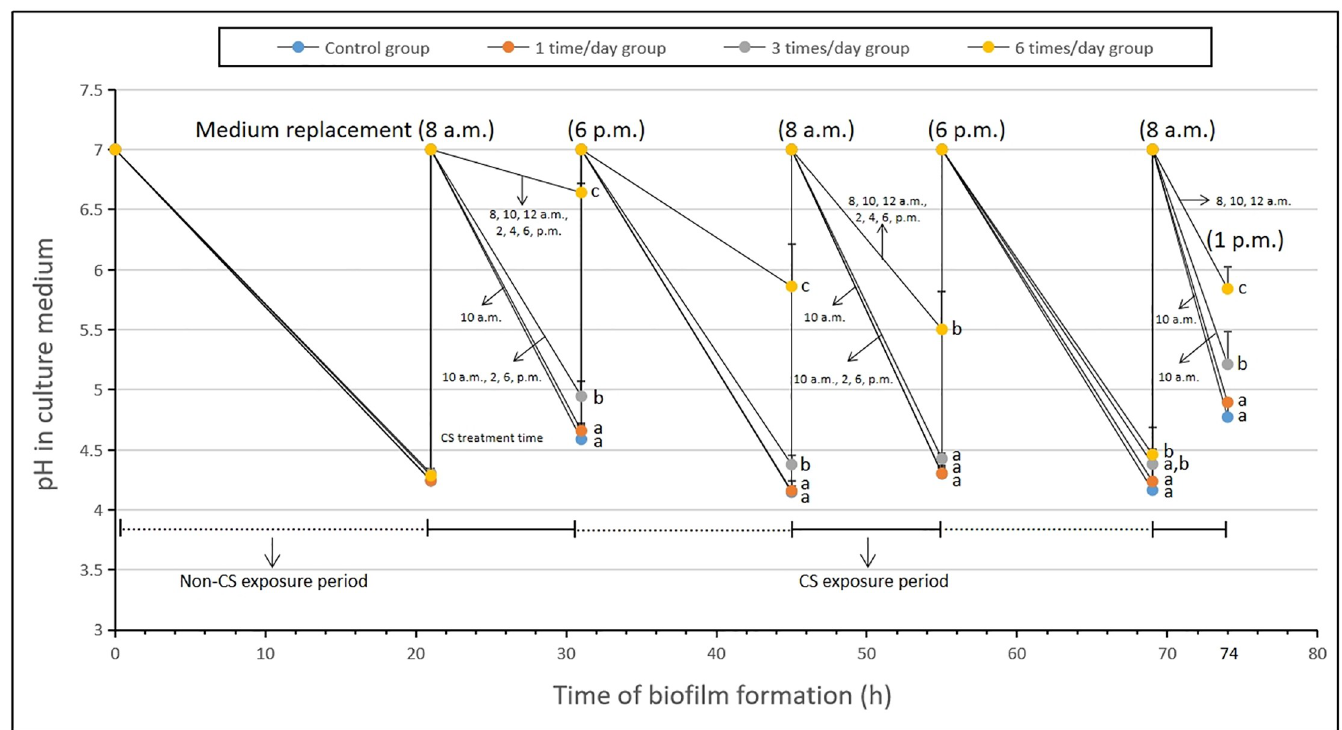
Fig 4. Change in the pH values of old culture medium exposure with CS during 74-h-old S . mutans UA159 biofilms formation. Data represent mean ± standard deviation. Values followed by the same superscript are not significantly different from each other ( p > 0.05).